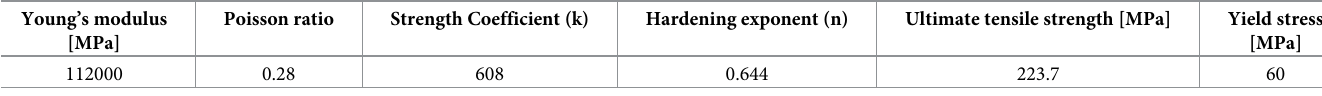
elements and nodes in an insert were 592 and 542, respectively, and the number of elements and nodes in the left and right punches were 32 and 56, respectively. To eliminate the effects of mesh dependency, the model results were compared with a finer mesh and an optimum mesh size was selected based on accuracy and computational time. The interface contact between the tube, die, two punches, and insert was simulated using the surface-to-surface one-way